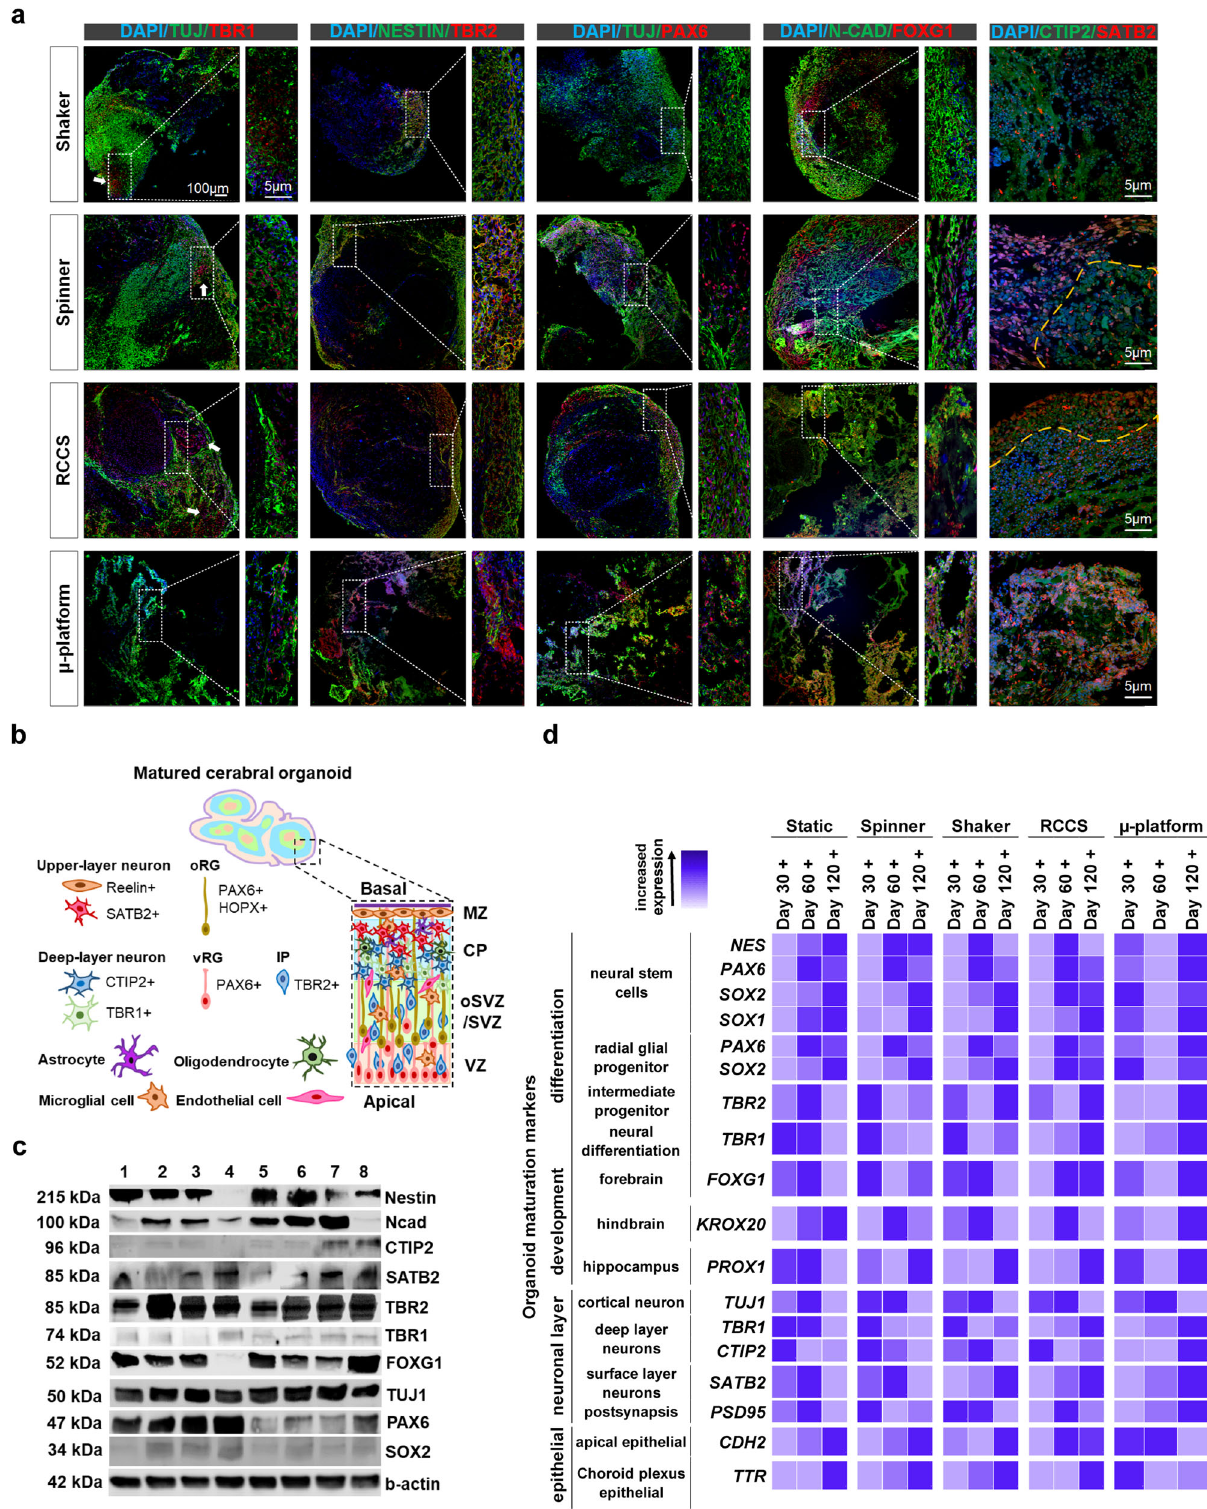
Fig. 2b, Supplementary Fig. 3, Supplementary Table 1). Paired box protein 6 (PAX6) is a transcription factor expressed in neural stem cells along with ventral forebrain radial glial progenitor cells and has an important role in the differentiation of radial glial cells located in different regions of the CNS, such as the cerebral cortex, cerebellum, forebrain, and hindbrain 59 . While localization of PAX6 + cells has been within the TUJ1 + zone with de fi